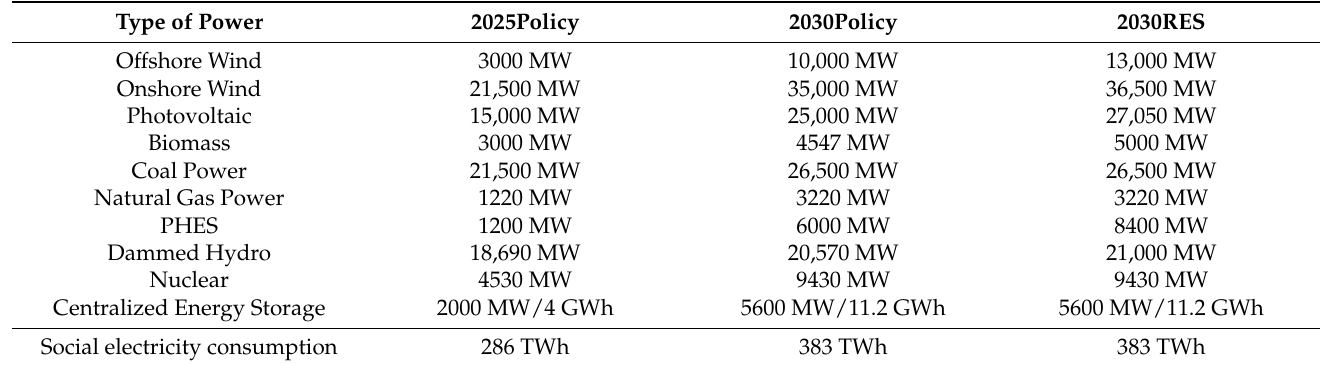
Table 5. The planning installed capacity of power generation technologies for Guangxi under policy scenarios in 2025 and